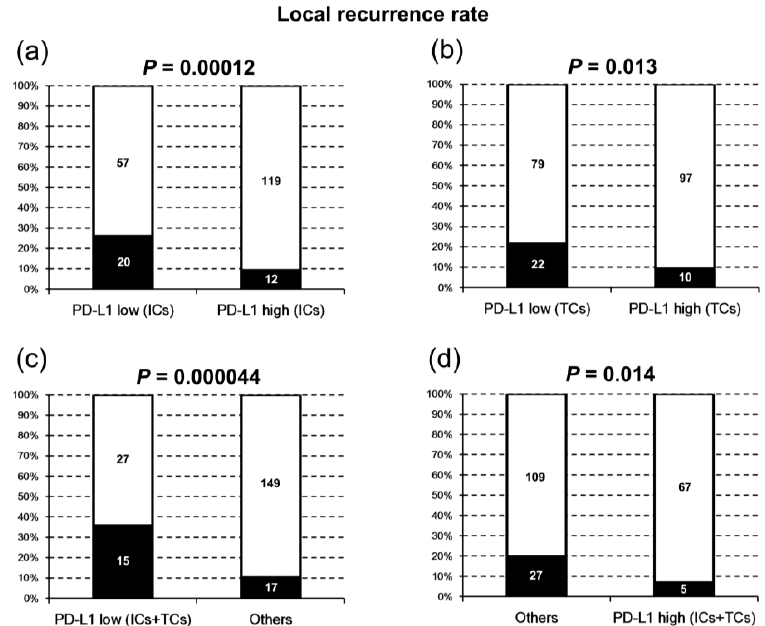
Figure 1. The local recurrence rates in patients with different levels of programmed death-ligand 1 (PD-L1) expression on immune cells (ICs) and tumor cells (TCs).